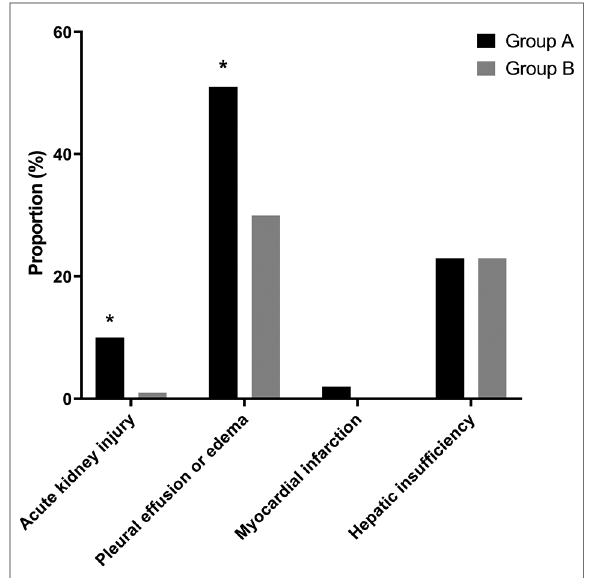
FIGURE 3 Incidence rates of postoperative complications including acute kidney injury, pulmonary edema or effusion, myocardial infarction, and hepatic insuf fi ciency. Among postoperative complications, the incidence rates of AKI (10.3% vs. 1.3%, P =0.004) and pleural effusion or edema edema (51.3% vs. 30.1%, P =0.013) are signi fi cantly higher in the patients with LVDD than in those with Normal LV diastolic function. * P <0.05, LVDD, left ventricular diastolic dysfunction; LV, left